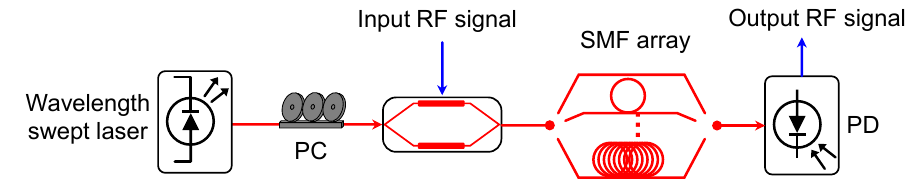
Figure 5. The experimental setup of the proposed microwave photonic frequency conversion system (the red curve is the optical signal; the black curve is the electrical signal).